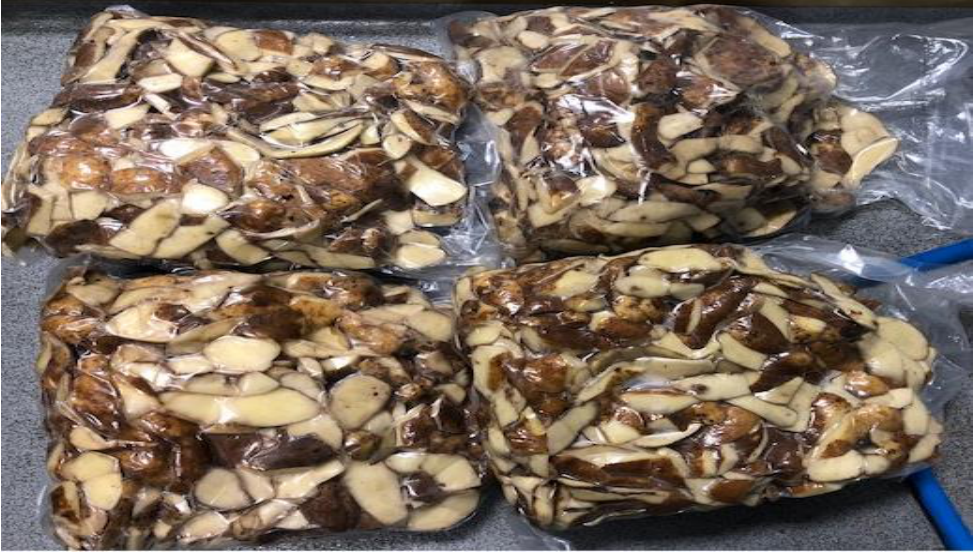
Figure 1. The potato peels.